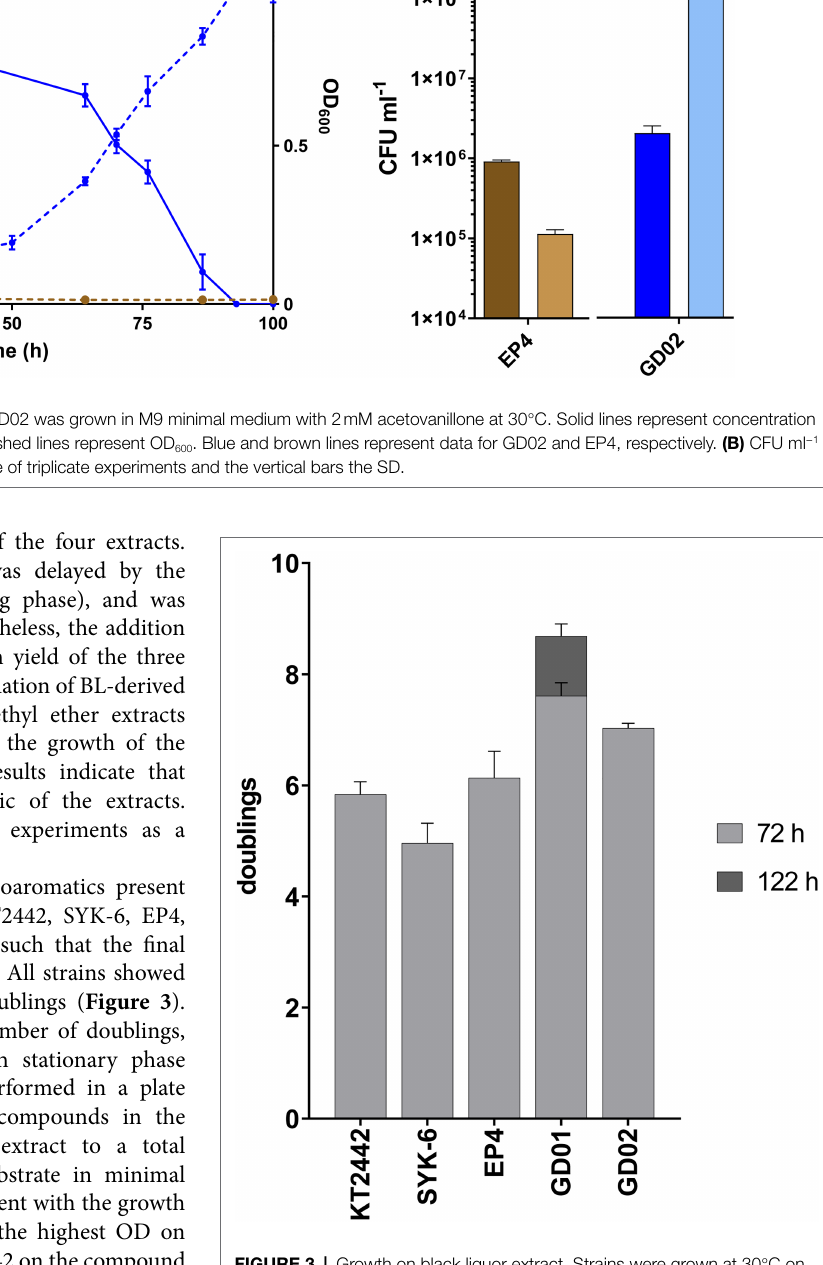
FIGURE 3 | Growth on black liquor extract. Strains were grown at 30 ° C on M9 minimal medium supplemented with acetone-extracted monoaromatic compounds to a total concentration of 1 mM. All strains hit stationary phase after 72 h, except for GD01 which was monitored until 122 h. Experiments were performed in